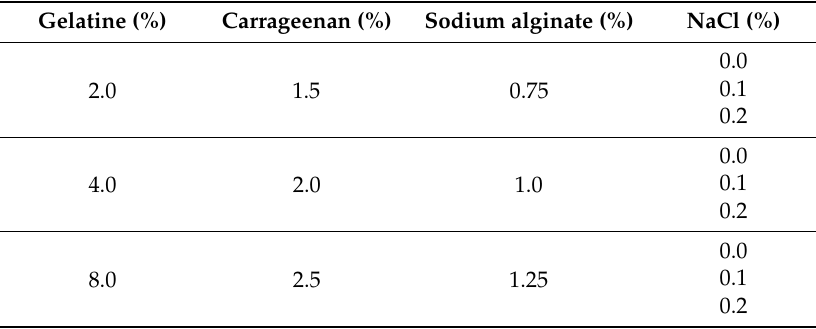
Table 1. The composition of the hydrosols.